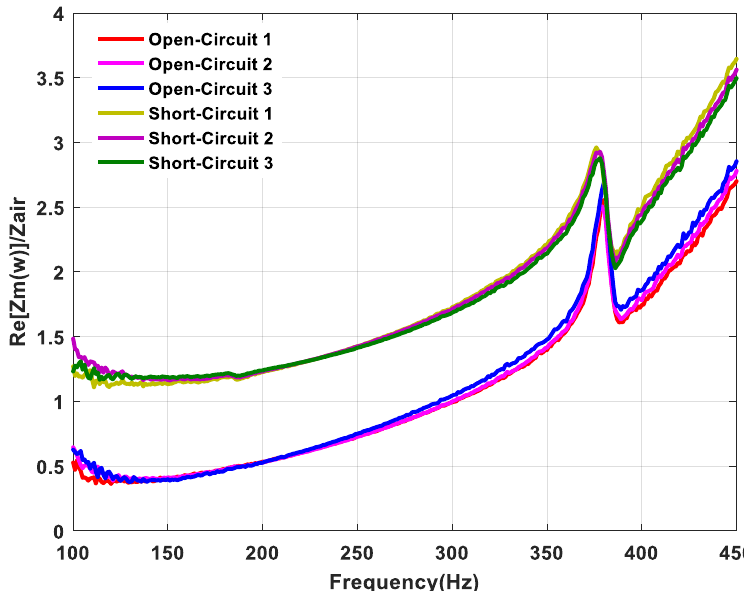
Figure 7. Short-circuit and open-circuit resistance comparison.